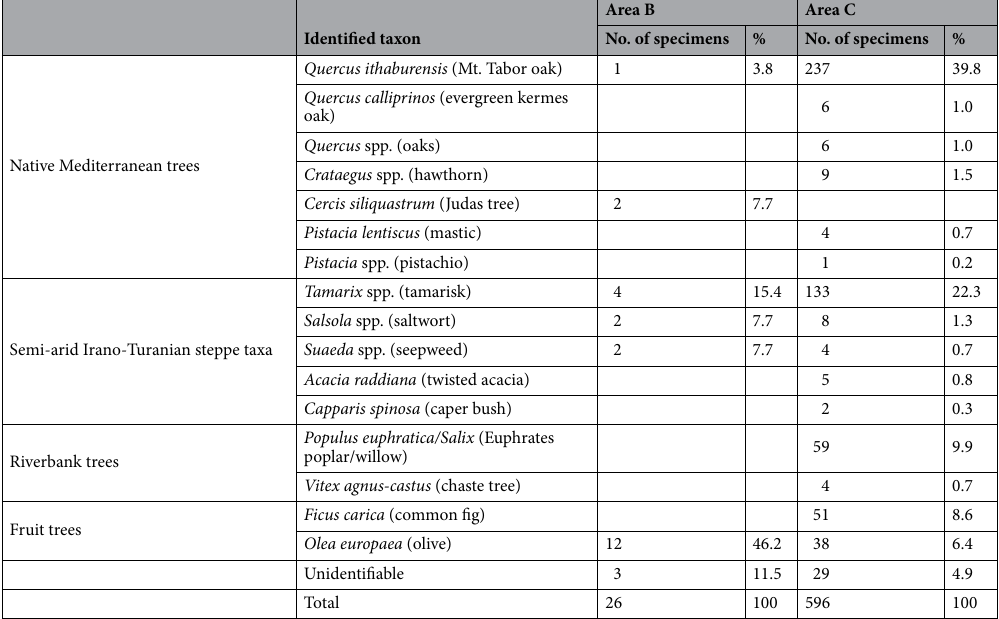
Table 1. Identified charred material in absolute numbers and percentages at Tel